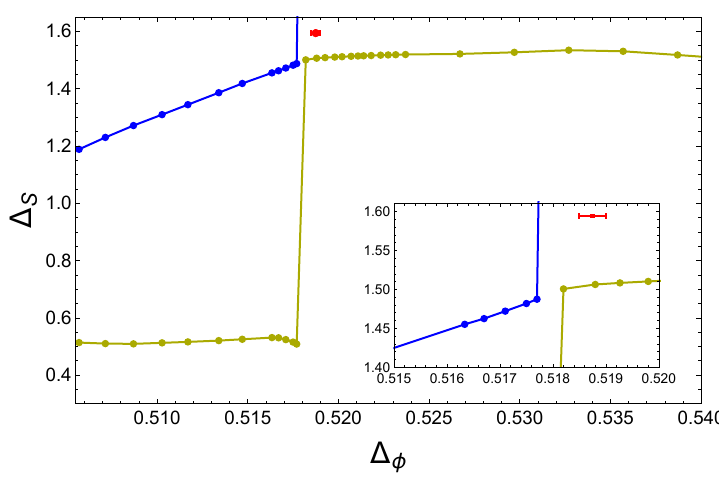
Figure 3 . The extremal functional obtained by minimizing the central charge and setting the n -channel gap to saturate the bound on ∆ n computed at Λ = 27, while the extremal functional itself is calculated at Λ = 23. The darker yellow and blue dots are the first and second operators respectively appearing in the extremal functional. The red error bars are the scaling dimensions of corresponding operators in the O(3) invariant Heisenberg model obtained using the Monte Carlo Method [106]. We have checked that suppose one increase Λ at which the extremal functional is calculated, the change of dots is no long visible by naked